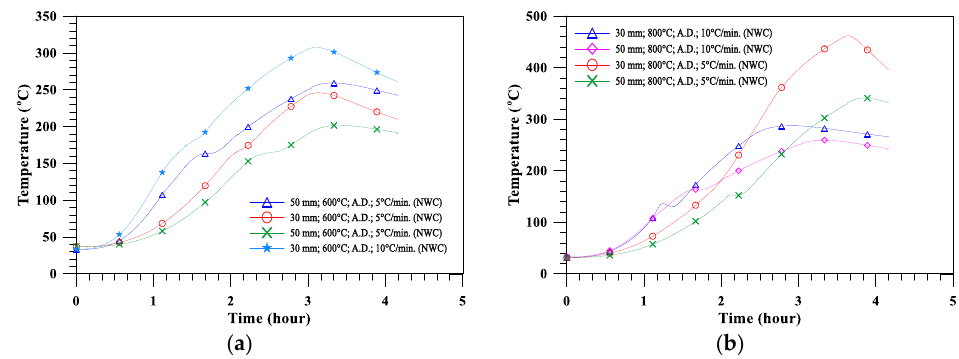
Figure 9. Comparison of the temperature distributions of the air-dried NWC specimens: ( a ) target temperature of 600 °C; ( b ) target temperature of 800 °C.